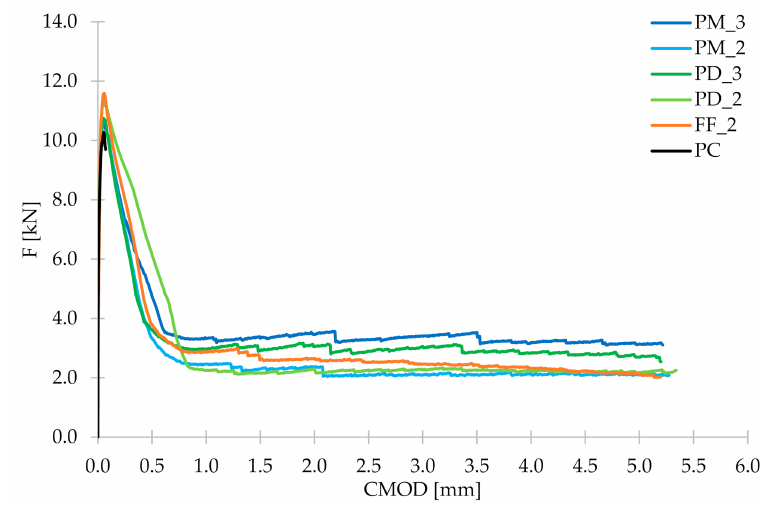
Figure 11. Graphs of mean F-CMOD curves for all concrete mixes. Table 8. Force values corresponding to the limit of proportionality (F L ) and CMOD = 0.5 (F 1 ); 1.5 (F 2 );